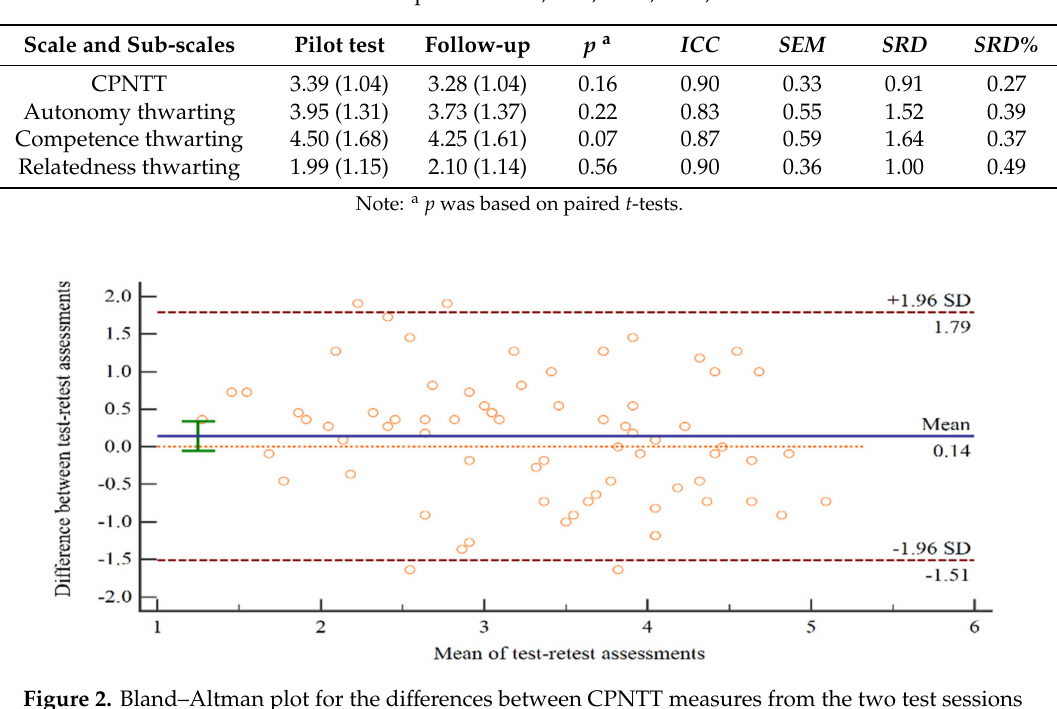
Table 4. Results for paired t tests, ICC, SEM, SRD, and SRD%.